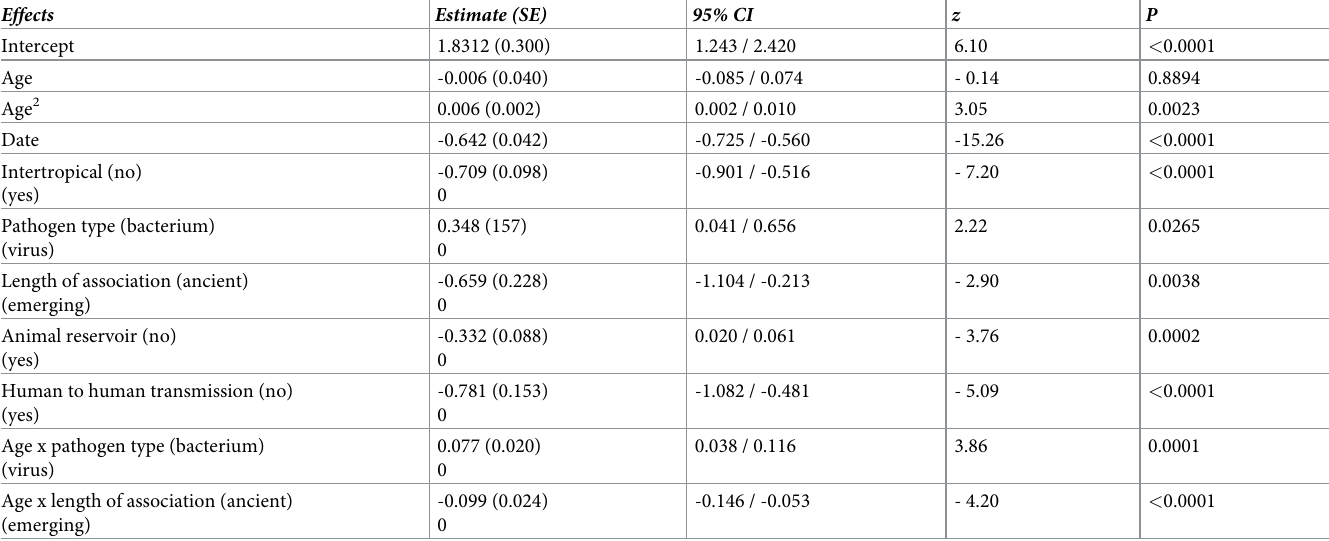
Table 3. Finite mixture model with a beta-binomial distribution of errors exploring the effect of pathogen type, length of association, animal reservoir, and human- to-human transmission on age-specific CFR (number of deaths/number of cases). The table reports the estimates (with SE and 95% CI), z and P values for the parame- ters retained in the model with the lowest BIC value. Number of observations = 873; number of deaths/number of cases =